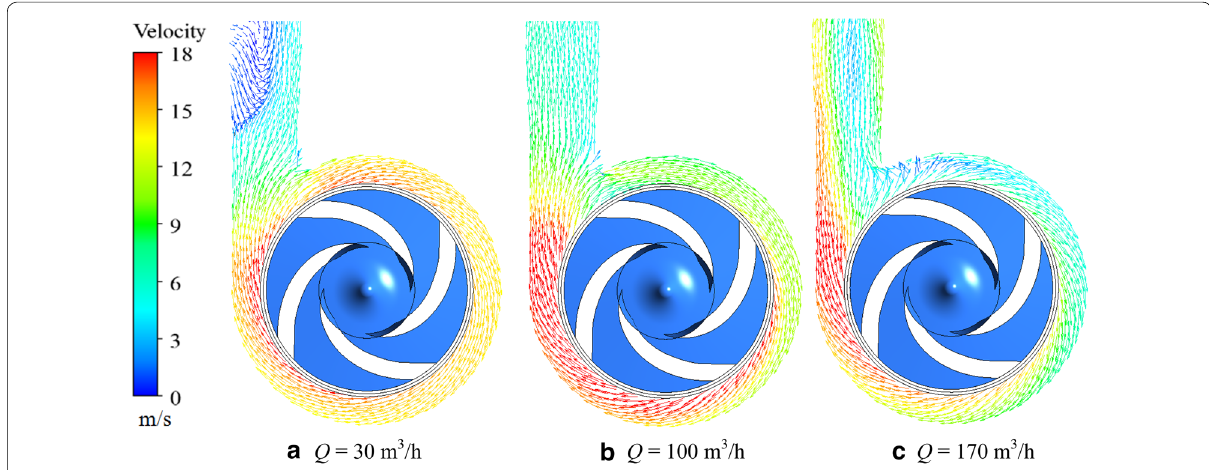
Figure 7 Velocity distribution at mid span of volute casing for case